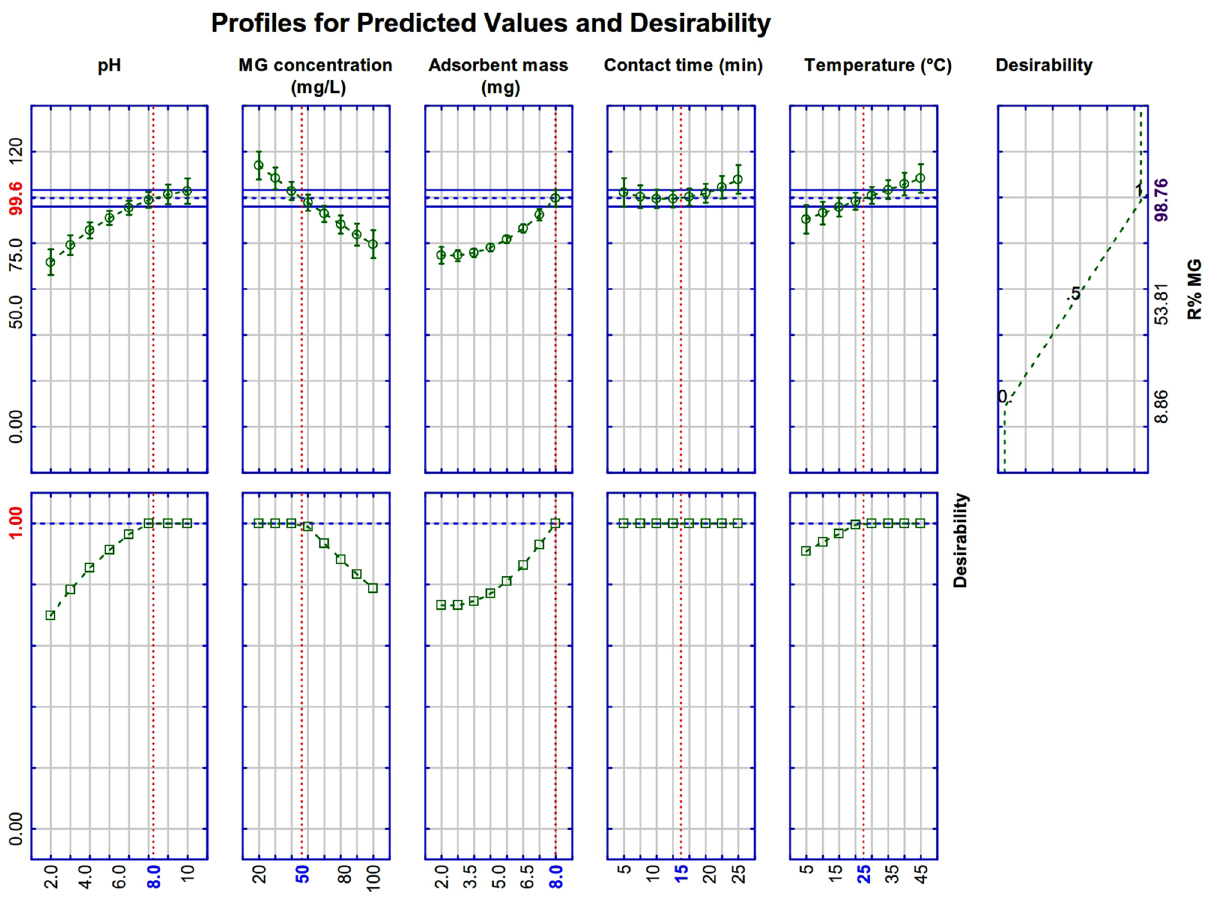
Figure 8. Optimal MG adsorption conditions from the model.